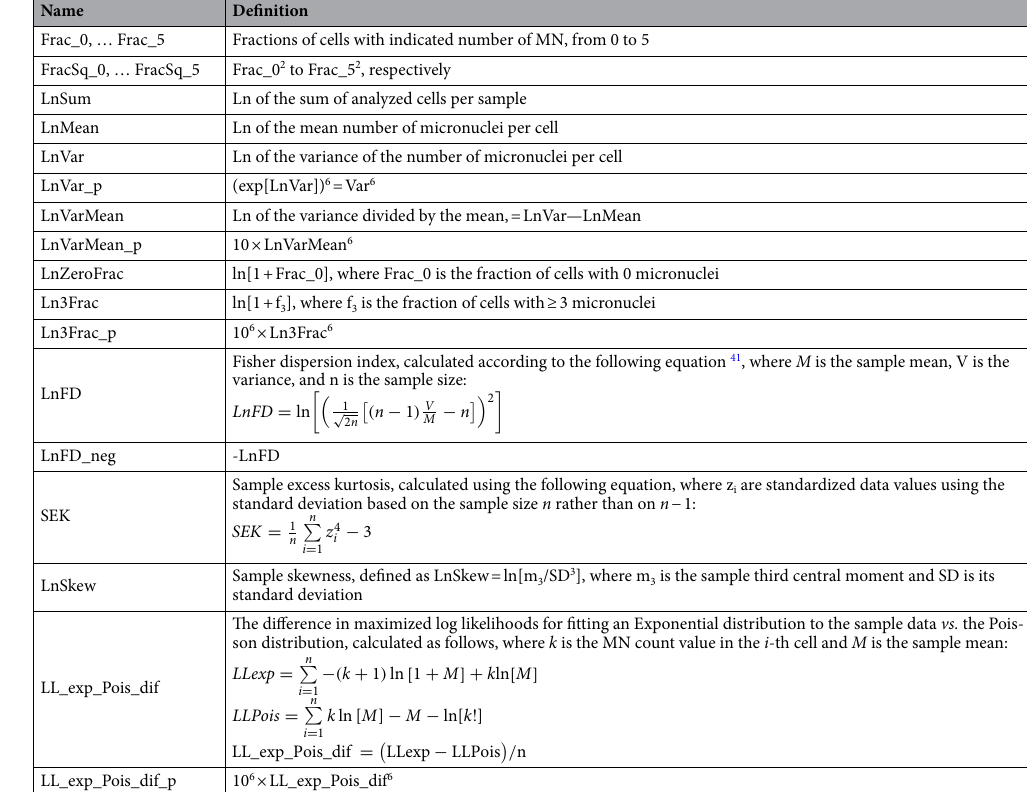
Table 1. Descriptions of predictor variables used in our analyses for neutron dose reconstruction. The prefix “Ln” indicates natural logarithm. M is the mean, V is the variance, and n is the number of cells in the analyzed sample. The predictor variables were selected based on our judgement, combined with information about overdispersion of cytogenetic damage from densely ionizing radiation exposures 32,33 . Some of the predictors represent versions of the same concept (e.g. LnVar and LnVar_p, LnFD and LnFD_neg). They were used because the random forest algorithm (described in the main text) can use only a subset of predictors in different decision trees to reduce correlations between predictions of different trees, so that only one version of a given predictor (not both) could be present in some trees.